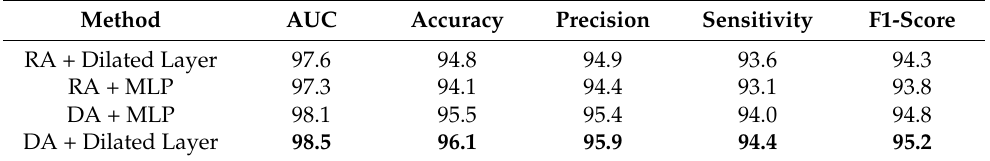
Table 2. Performance comparisons of each component in the Deformable Dilated Transformer. Method